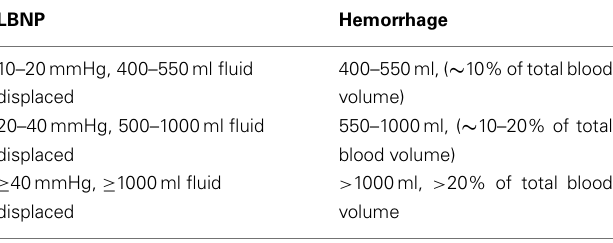
Table 1 | Ranges of fluid displacement induced by lower body negative pressure and equivalent amounts of blood loss during hemorrhage.